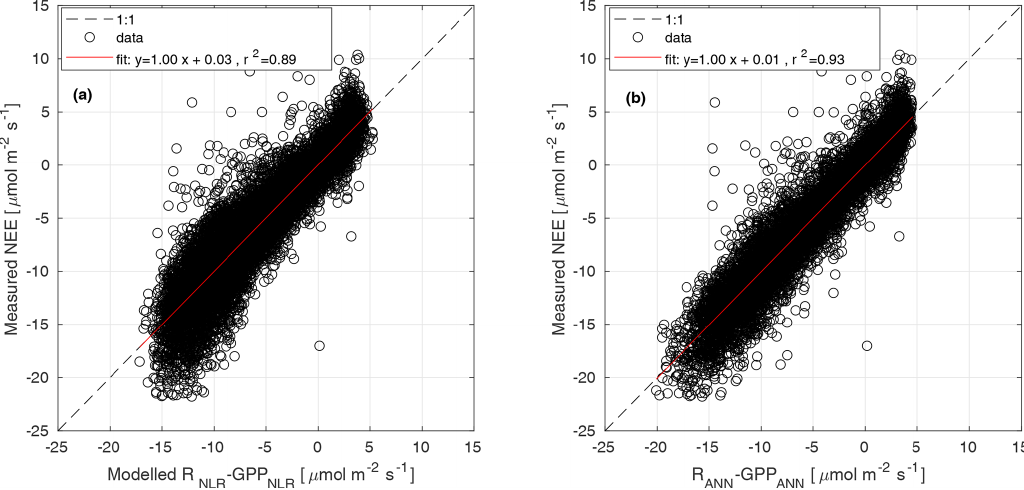
Figure B1. Modelled against measured NEE using (a) NLR and (b) ANN models for modelling NEE.